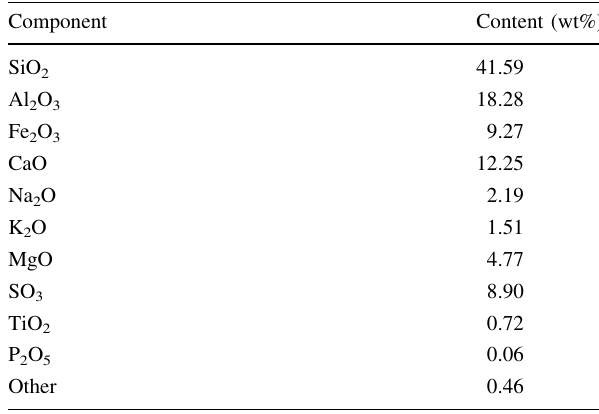
Table 2 Ash chemical compositions of